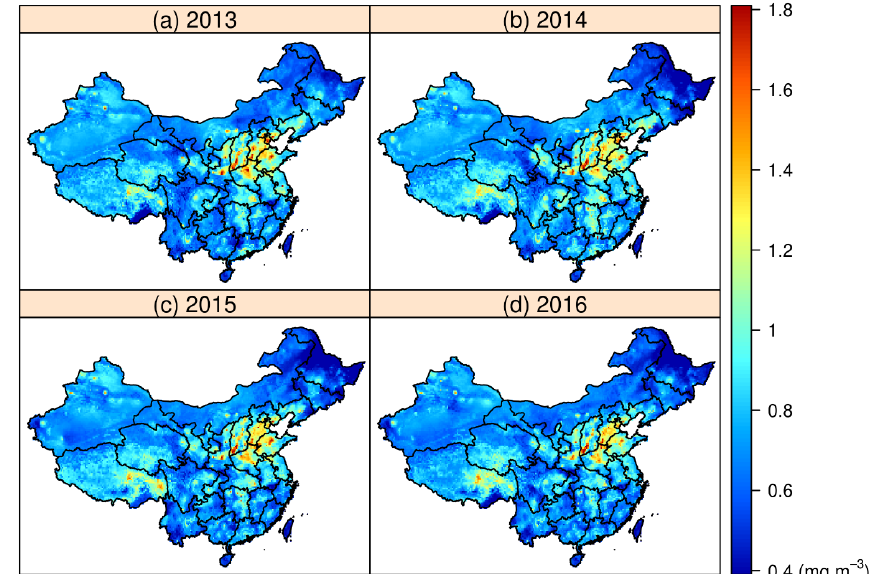
Figure 7. Annual average ground-level CO concentrations predicted by the RF–STK model for (a) 2013, (b) 2014, (c) 2015, and (d) 2016 across